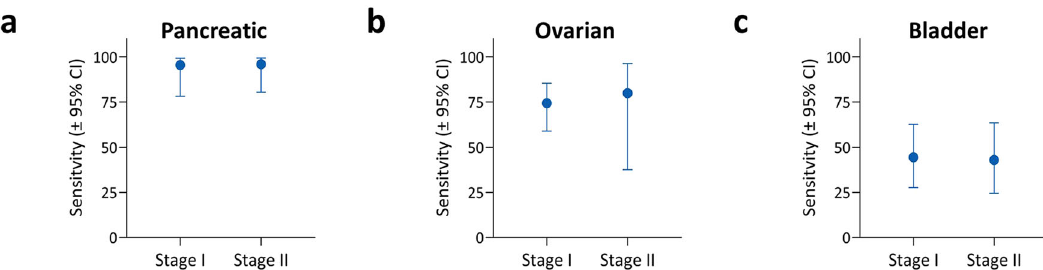
Fig. 5 Sensitivities by stage for simultaneous detection of three cancer types using EV protein biomarkers. a Sensitivity for detecting either stage I ( N = 22) or stage II ( N = 25) pancreatic cancer. b Sensitivity for detecting either stage I ( N = 39) or stage II ( N = 5) ovarian cancer. c Sensitivity for detecting either stage I ( N = 27) or stage II ( N = 21) bladder cancer. All sensitivities represent values at >99% speci fi city for the held-out test sets. Error bars in all panels represent the two-sided 95% Wilson con fi